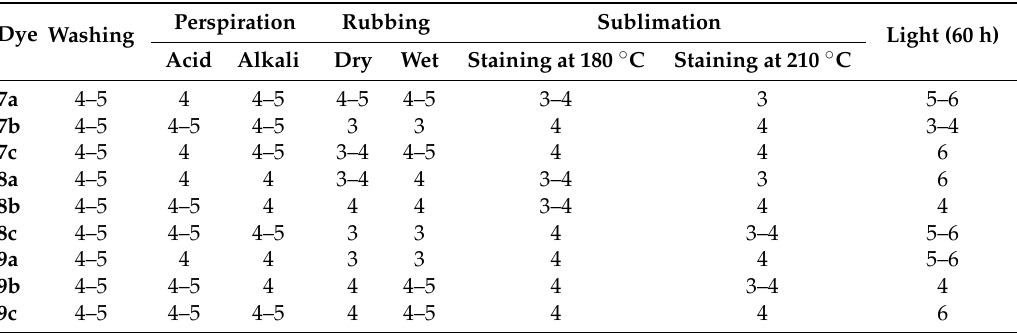
Table 1. Fastness properties of the synthesized dyes on polyester